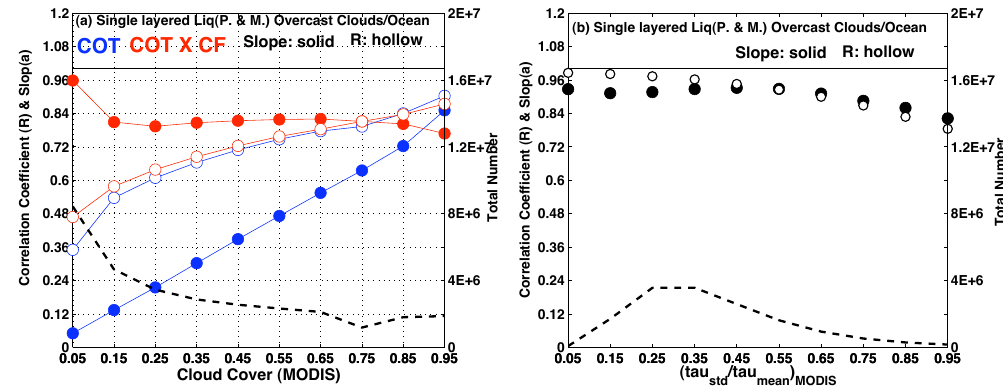
Fig. 6. Slopes and correlation coefficients, R , of the relationship between POLDER and MODIS COT in blue and between POLDER and MODIS COT × CF in red in function of MODIS cloud cover (a) . Slopes and correlation coefficients of the relationship between POLDER and MODIS COT in function of cloud inhomogeneity from MODIS (b) . Only the liquid overcast (for POLDER and MODIS) clouds over ocean are considered. Dashed curves represent the number of samples in each case.